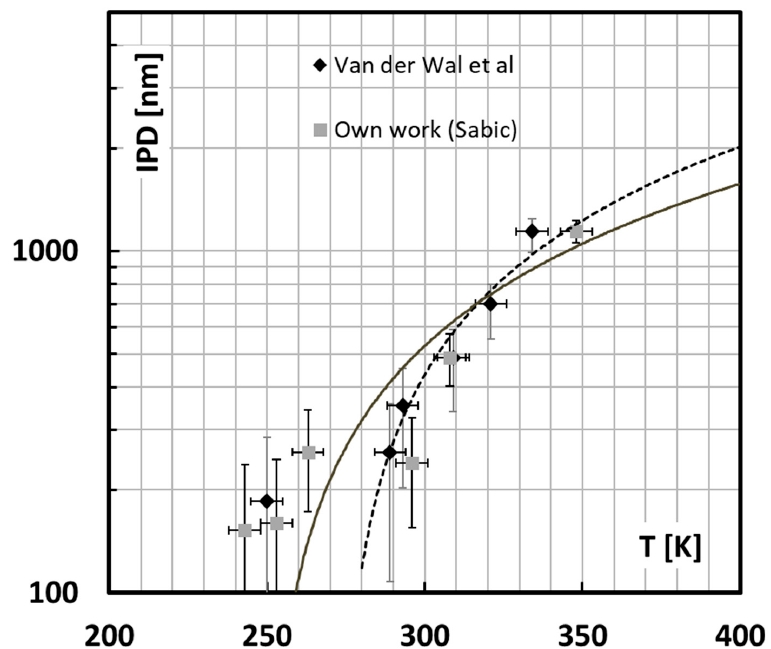
Figure 12. Comparison between experimental data from SABIC (grey squares) and Van der Wal et al. (black diamonds) represented on average by the solid line and the theoretical prediction (dotted line) using Equation (13).